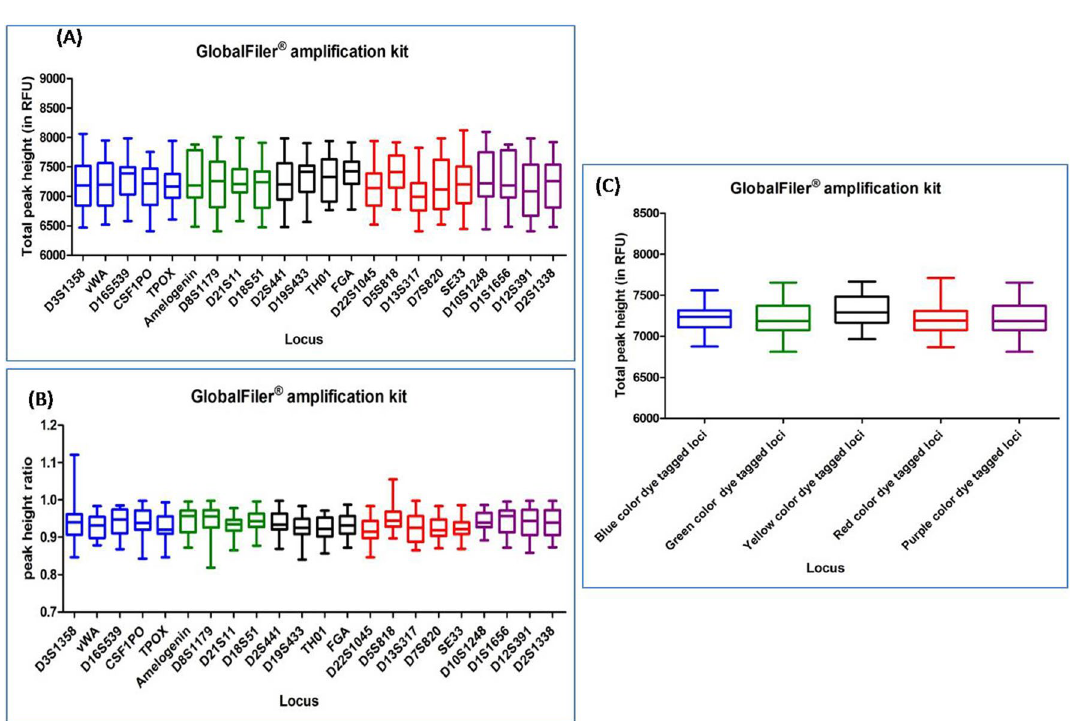
Figure 8. Quality assessment of DNA profile by Dunn’s multiple comparison test for the GLOBALFILER PCR AMPLIFICATION KIT ( A ) Total peak height ( B ) Peak height ratio ( C ) Global